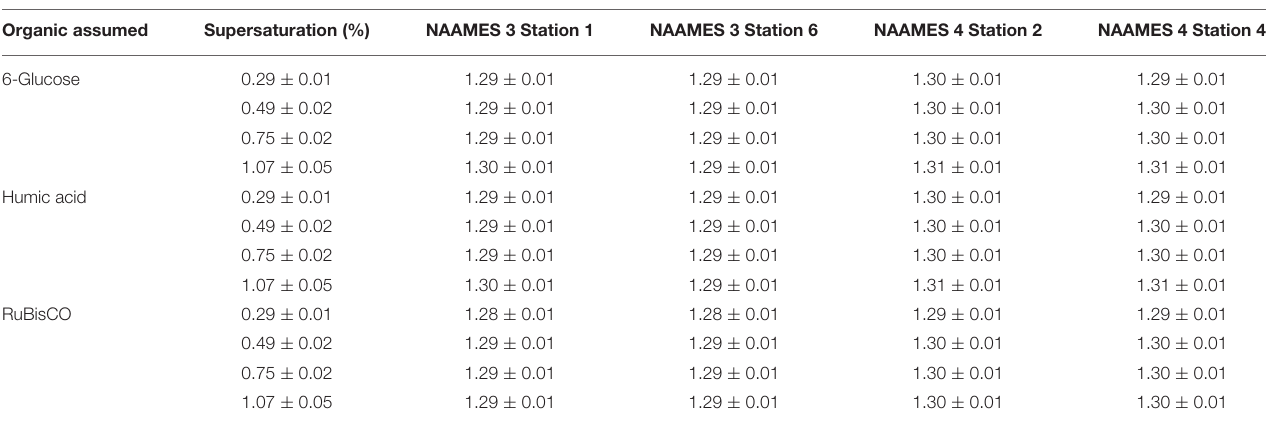
TABLE 4 | Predicted κ values for SML samples varying organic